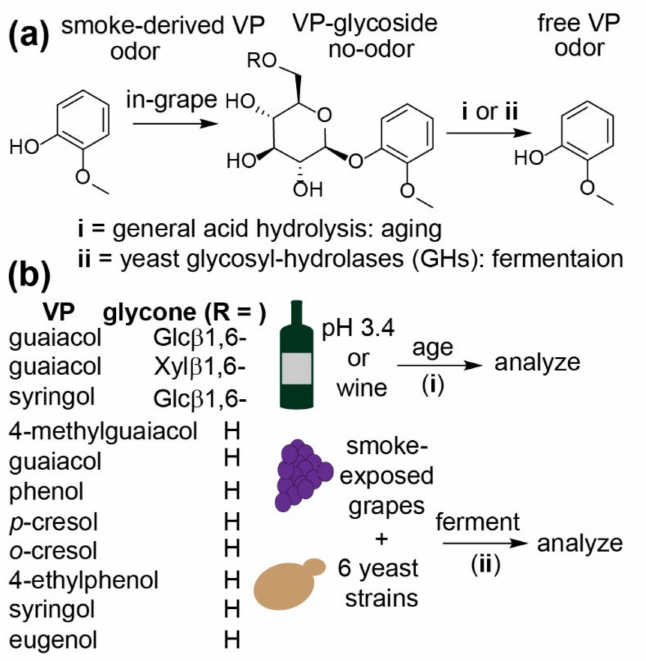
Figure 1. ( a ) Smoke-derived VPs are stored within ripening grape tissues as mono- β - D -glucosides (R = H) or a range of larger disaccharides (R = β -xylose, β -glycose, α -rhamnose, etc.), none of which possess the characteristic smoky odor of the free VPs. The hydrolysis of these VP-glycosides may be catalyzed either by the acidic pH of wine (i) or by the activity of yeast/bacterial glycosyl- hydrolases (ii), resulting in increased concentrations of free VPs during aging or primary fermentation, respectively. ( b ) Three VP-disaccharides (R = glucose (Glc) or xylose (Xyl)) and eight VP-mono- β - D - glucosides (R = H) were added to model and real wines to assess their stability towards hydrolysis; additionally, the same suite of model VP-glycosides was added to smoke-exposed grapes and matched controls to evaluate the ability of differing commercial yeast strains to affect their hydrolysis during primary